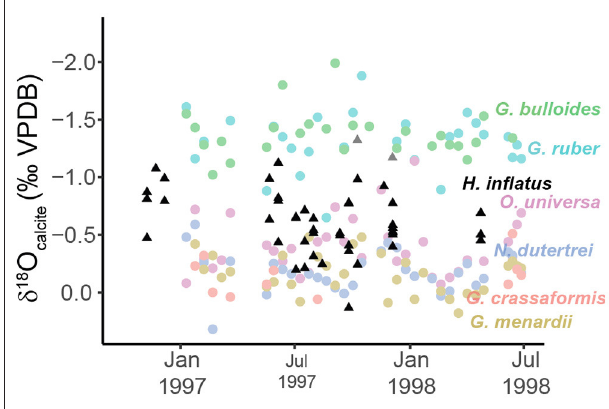
FIGURE 8 | Scatter plot showing the oxygen isotopic composition of six species of foraminifera (colored circles) (Tedesco et al., 2007) and one species of pteropod (black triangles) (this study) from CARIACO sediment trap A (150m water depth) between October 1996 and July 1998. Because aragonite and calcite have different fractionation factors relative to ambient seawater, the oxygen isotopic composition of pteropods (aragonite) are adjusted using the calibration from Böhm et al. (2000) (black triangles, 1 ‰ offset) to plot in calcite